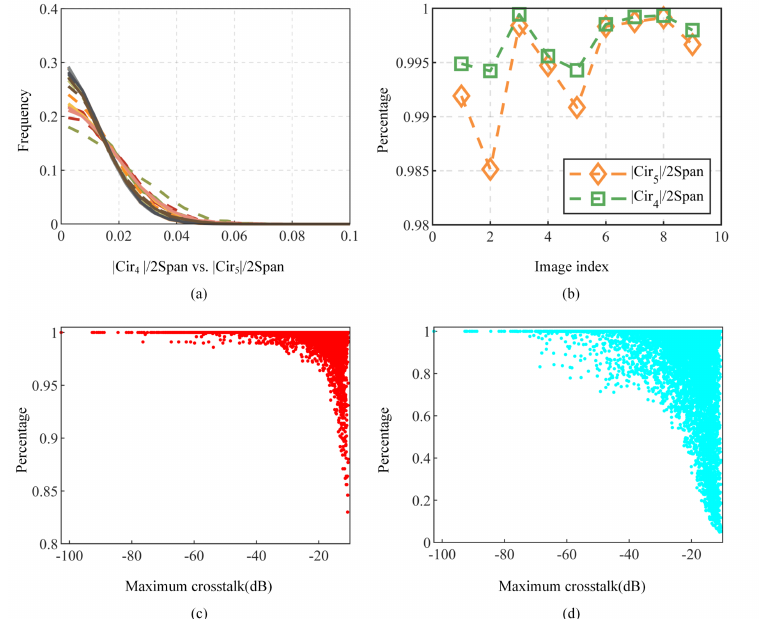
| /2Span: ( a ) histograms of | Cir | /2Span and | Cir Figure 3. Comparison of | Cir 5 4 | Cir | /2Span in the volume-dominated area of nine undistorted CQP SAR images; ( b ) percentages of 5 all volume-dominated points with | Cir 4 | /2Span < 0.1 and | Cir 5 | /2Span < 0.1 in each undistorted CQP SAR image; ( c , d ) percentages of all reflection symmetry points with | Cir 4 | /2Span < 0.1 and | Cir | /2Span < 0.1 in the presence of reciprocal 5